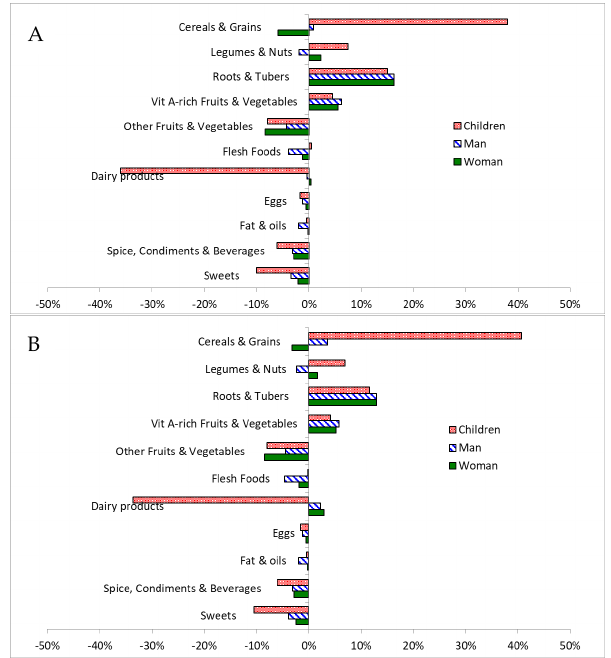
Figure 3. Relative differences between the nutritionally adequate rural (Panel A ) and urban (panel B ) FB for an Ethiopian family of five affordable for ETB 71.24 and the reported average consumption of eleven food categories in Ethiopia [4].